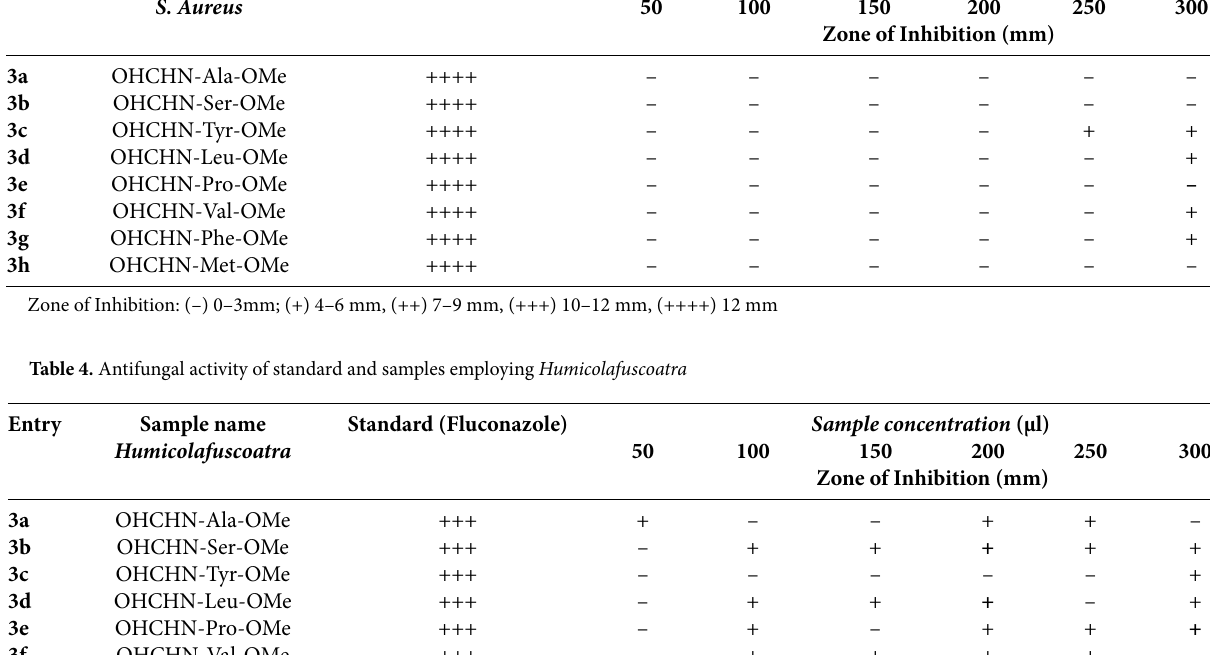
Table 3. Antibacterial activity of standard and samples employing S. Aureus Entry